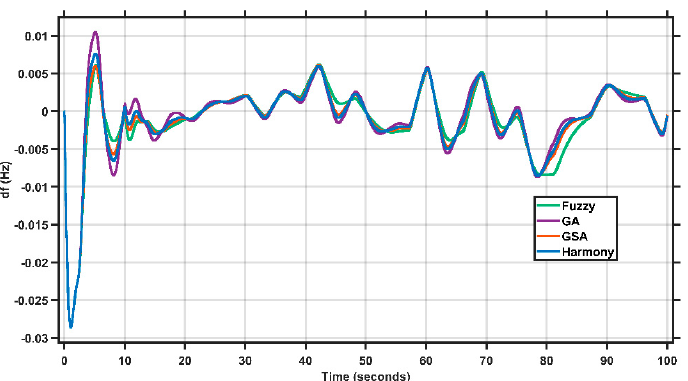
Figure 14. The frequency deviation under wind disturbance.